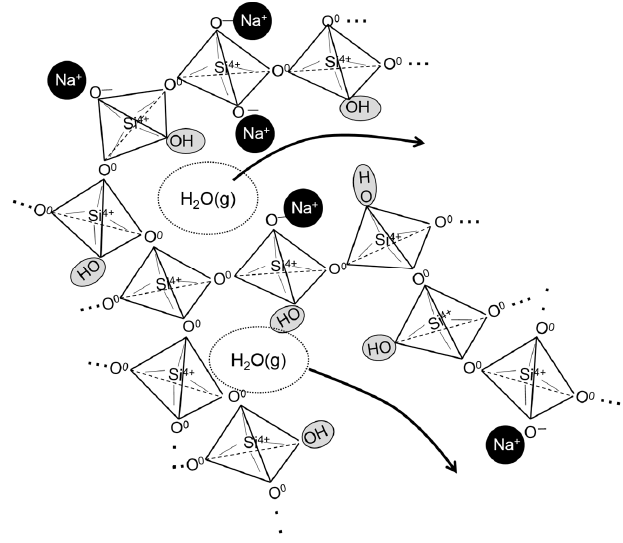
Figure 5. Schematic illustration of H 2 O vapor emission from glass microscopic structure when reheating the hydrothermally treated glass.